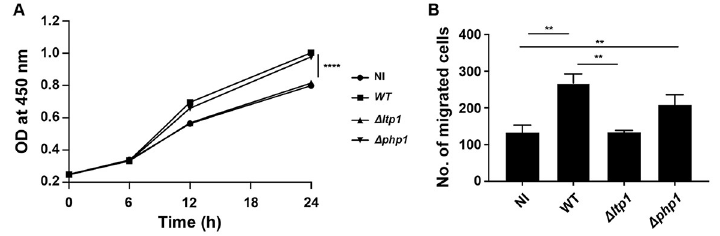
Fig 1. Ltp1 is required for proliferation and migration induced by P . gingivalis in TIGKs. A) BrdU proliferation ELISA of TIGKs challenged with P . gingivalis WT, Δ ltp1 , Δ php1 , or left uninfected (NI). Absorbance at 450 nm was measured over the times indicated and the results are representative of 3 biological replicates. B) Quantitative analysis of TIGK migration through Matrigel-coated transwells. TIGK cells were challenged with P . gingivalis WT, Δ ltp1 , Δ php1 , or left uninfected (NI). Data are the mean with SD number of cells invading through inserts coated with Matrigel, and are representative of 3 biological replicates. �� p < 0.01, ���� p <